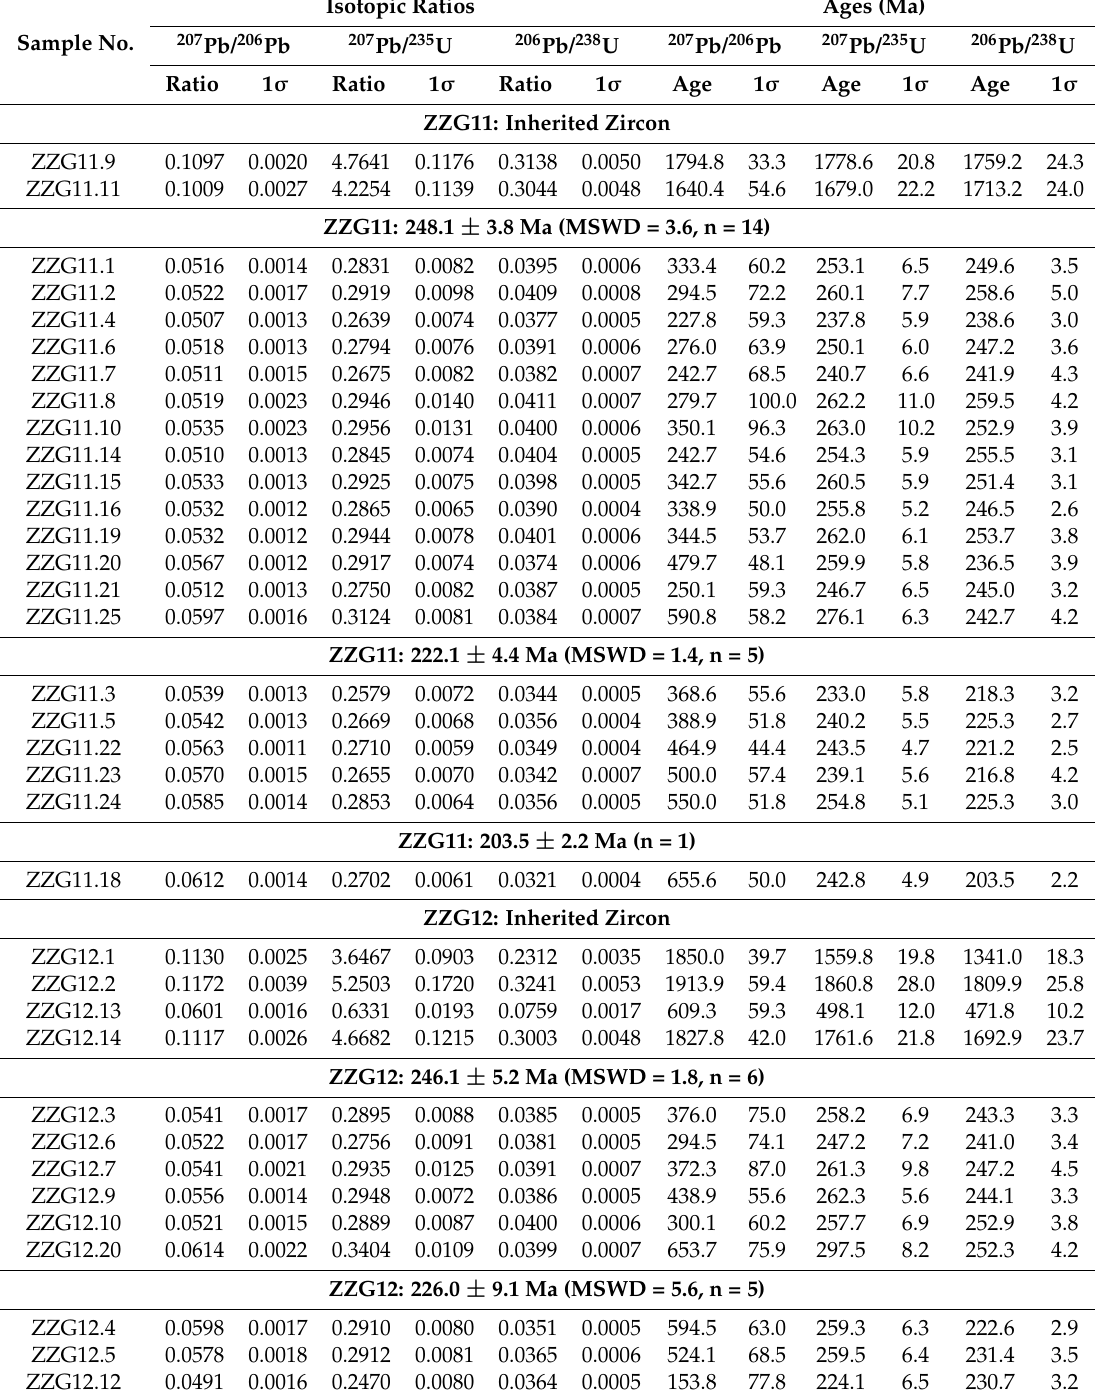
Table 1. LA-ICP-MS zircon U-Pb dating results of porphyritic dacite samples ZZG11 and ZZG12.